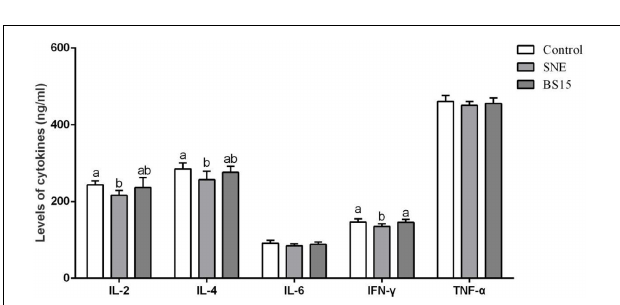
FIGURE 9 | Levels of cytokines in the serum (Experiment 2). Bars with different letters are significantly different on the basis of Duncan’s multiple range tests ( P < 0.05). Data are presented as mean ± standard deviation (six replicates of one chick per cage). TNF- α tumor necrosis factor-alpha; INF- γ